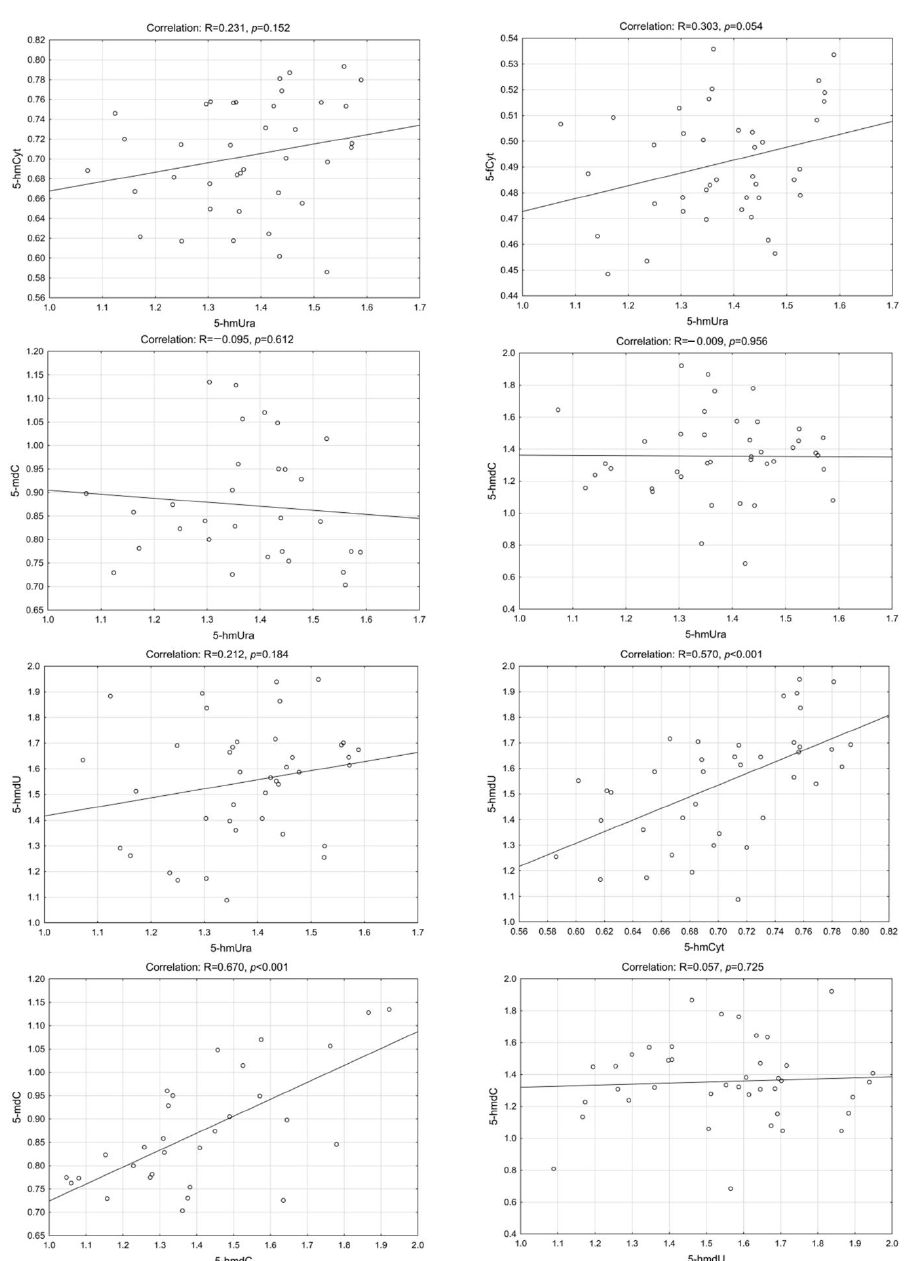
Figure 2. Selected correlations between the levels of DNA epigenetic modifications in urine—control group. 5-hmCyt: 5-hydroxymethylcytosine; 5-hmUra: 5-hydroxymethyluracil; 5-mdC: 5-methyl-2′-deoxycytidine; 5-hmdC: 5-(hydroxymethyl)-2′-deoxycytidine; 5-hmdU: 5-(hydroxymethyl)-2 (cid:48) - deoxyuridine; 5-fCyt: